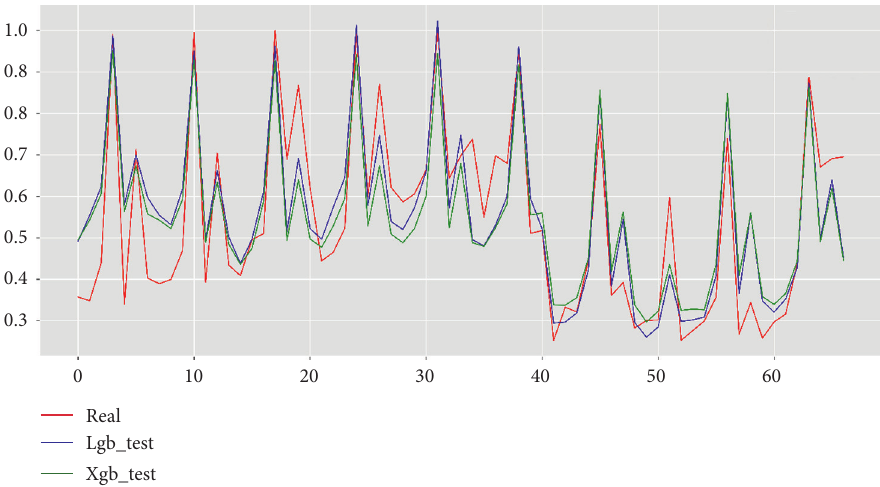
Figure 5: Prediction results of LightGBM and XGBoost.